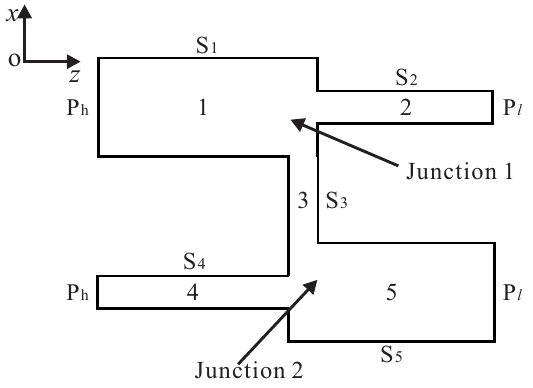
Figure 8. Cross section with the maximum pore area normal to direction y for an idealized porous medium. P h and P l are the inlet and outlet pressures, respectively. Tubes 1, 2, and 3 meet at junction 1 and tubes 3, 4, and 5 meet at junction 2.